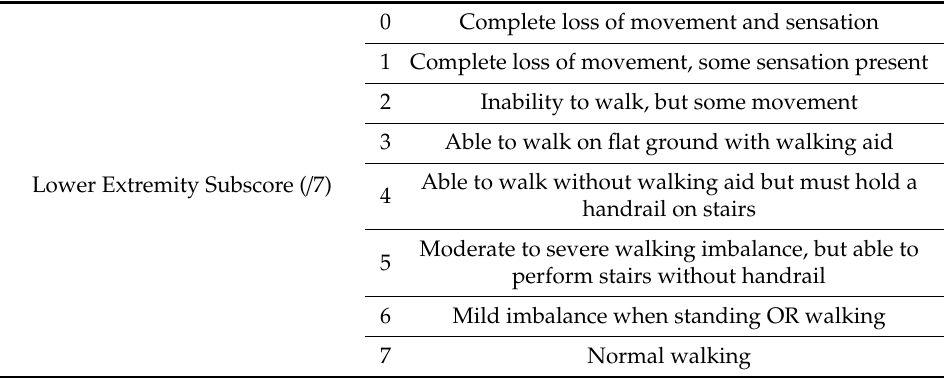
Table 1. Lower extremity subscore of modified Japanese Orthopaedic Association scale (mJOA). 0 Complete loss of movement and sensation 1 Complete loss of movement, some sensation present 2 Inability to walk, but some movement 3 Able to walk on flat ground with walking aid Able to walk without walking aid but must hold a Lower Extremity Subscore ( / 7) 4 handrail on stairs Moderate to severe walking imbalance, but able to 5 perform stairs without handrail 6 Mild imbalance when standing OR walking 7 Normal